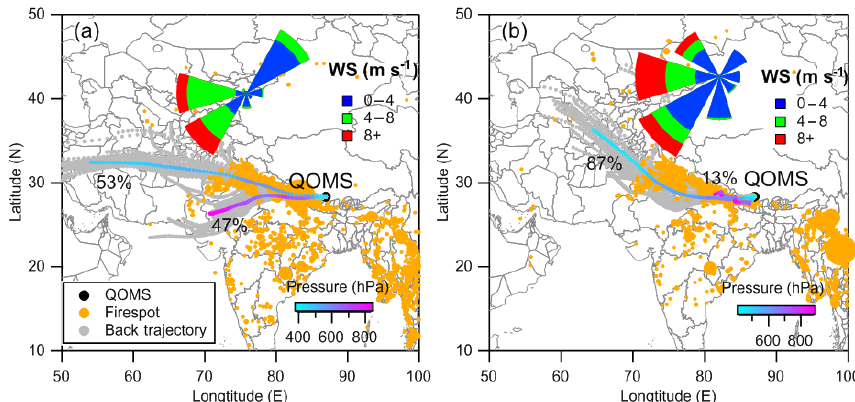
Figure 2. The air mass back trajectory analysis using the HYSPLIT model (Draxler and Hess, 1998) during (a) P1 and (b) P2. The air mass trajectories were recovered back to 72 at a 1h interval from the sampling site (QOMS) at 1000m above ground level using a 1 ◦ resolution Global Data Assimilation System (GDAS) dataset (https://ready.arl.noaa.gov/gdas1.php; last access: 10 September 2017). The cluster analysis for these trajectories was completed based on the directions of the trajectories (angle distance) and colored according to air pressure (vertical profile). The firespot observed from MODIS (https://firms.modaps.eosdis.nasa.gov; last access: 10 September 2017) and the average wind rose plot colored by wind speed (WS) for during each filter sampling period are also shown. The firespot is sized by fire radiative